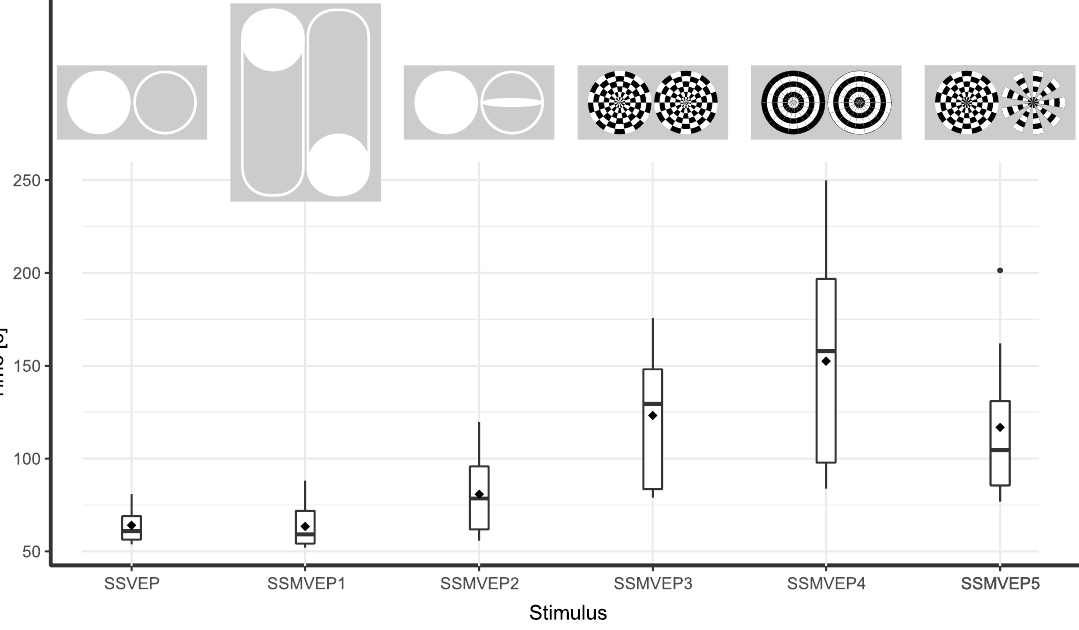
Figure 3. Spelling times of the word “INVITE” which was the main task consisting of 18 trials. The bar inside the box represents the median value and the ◇ points the mean values. Above the results presented are the stimuli at the beginning and in mid-cycle of the stimulation